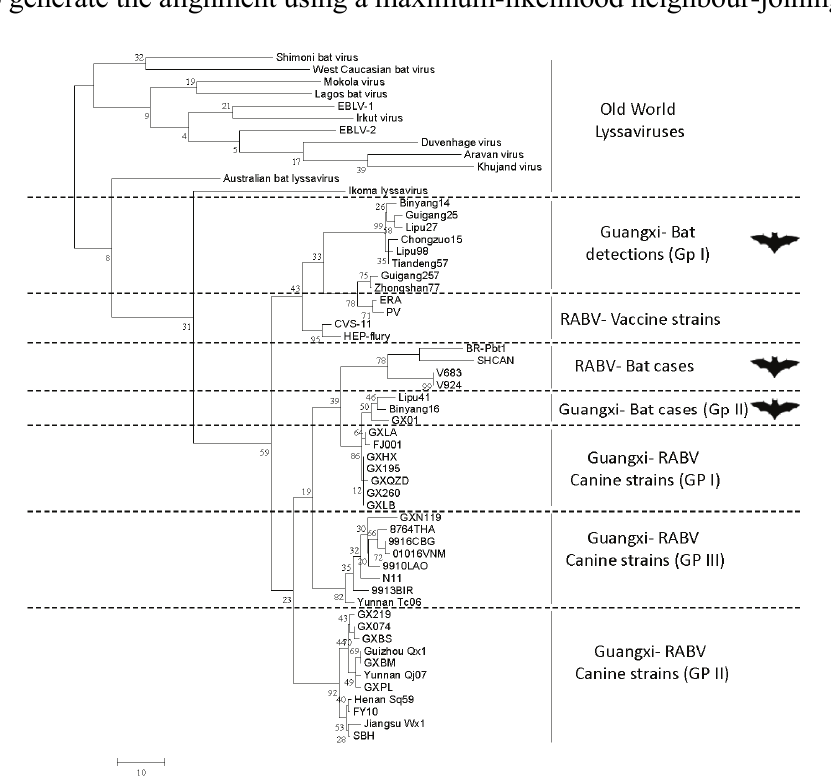
Figure 3. Phylogenetic analysis of lyssavirus sequence data derived from bats in China with rabies and other lyssaviruses. A comparison of 260 nucleotides of the nucleocapsid gene was used to generate the alignment using a maximum-likelihood neighbour-joining